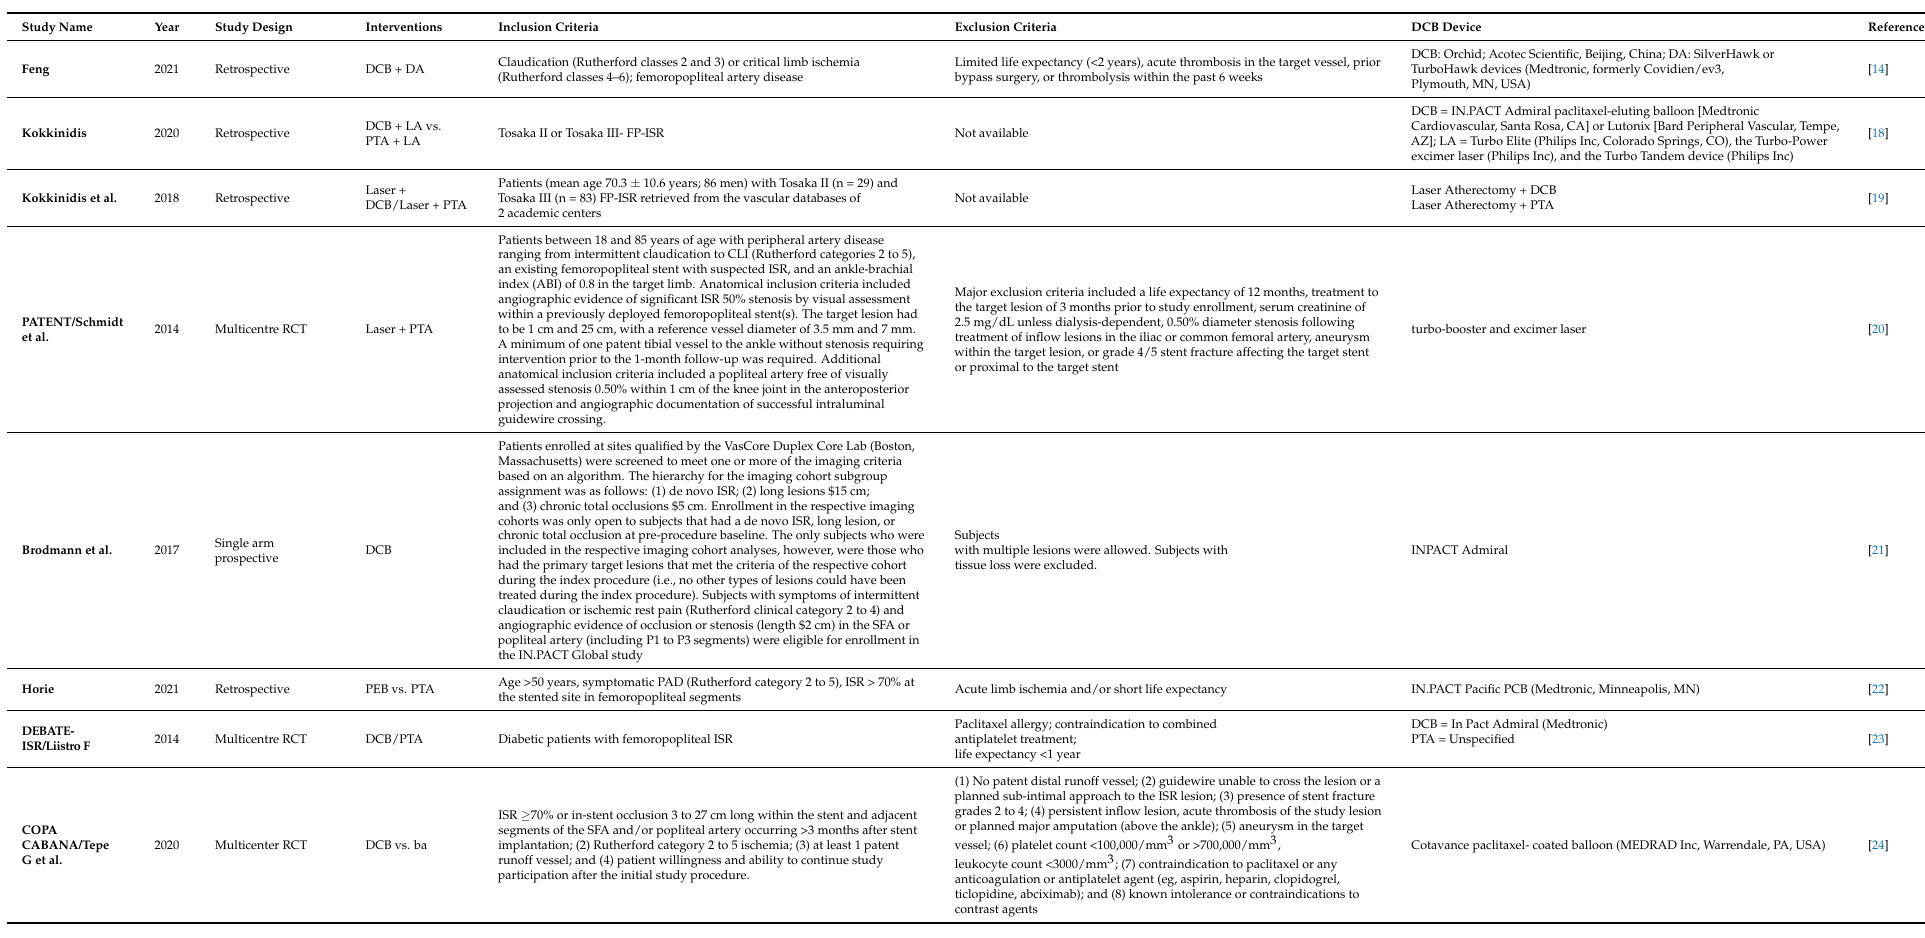
Table 1. Study design of the included